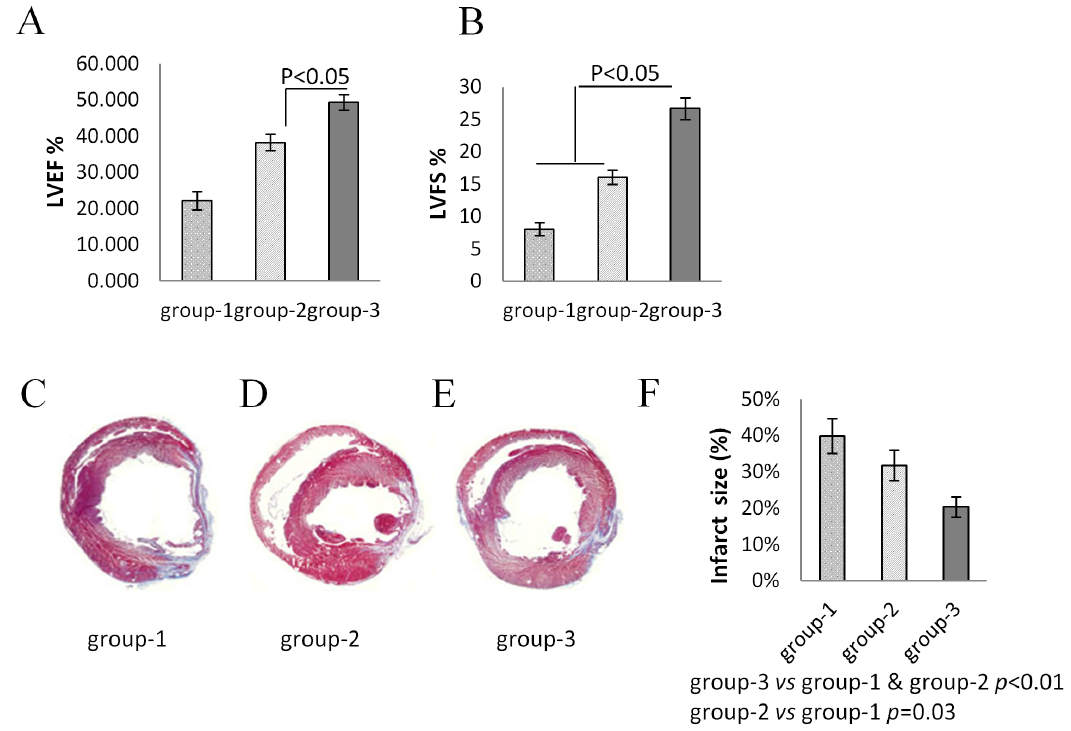
Figure 7. PKG1 a MSCs improved cardiac function and attenuated infarction size. At 4 weeks after transplantation, (A and B) transthoracic echocardiography was performed to assess global heart function. Both LV ejection fraction (LVEF) and fractional shortening (LVFS) were significantly preserved in group-3 compared to group-1 and group-2 ( p , 0.05). (C–F) Quantitative assessment on the rat heart sections with mason trichrome staining showed a significant attenuation of infarct size in group-3 compared with group-1 and group-2 ( p , 0.01)